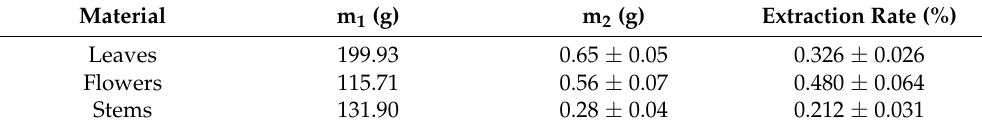
Table 1. Experimental results of extraction of camphor tree leaf, flower and stem by steam distillation. Material m 1 (g) m 2 (g) Extraction Rate (%) Leaves 199.93 Flowers 115.71 Stems 131.90 0.212 ±